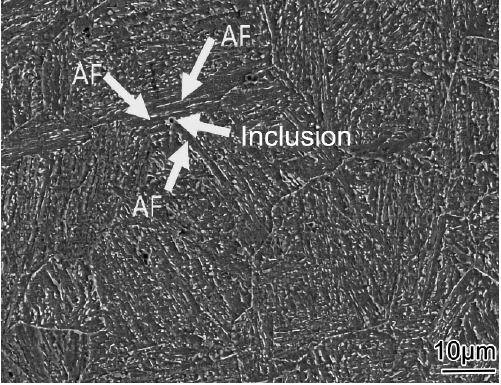
Figure 10. Nucleation of acicular